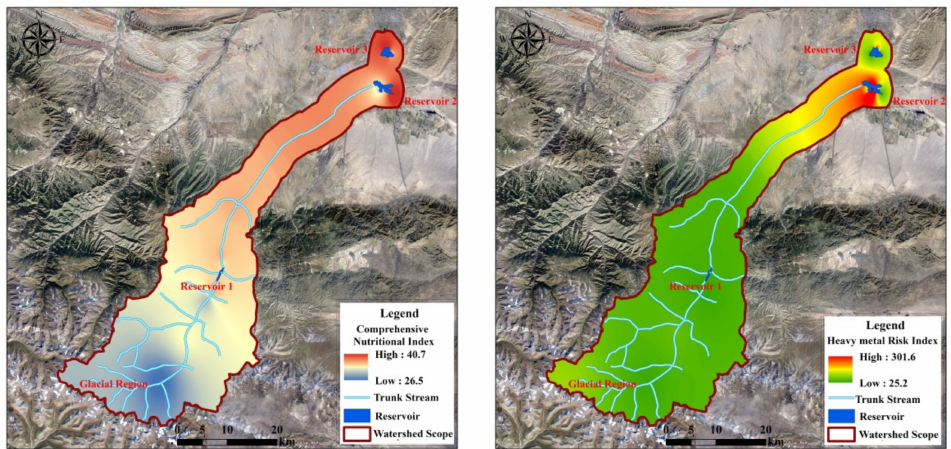
Figure 7. Scoring results for the comprehensive nutritional index ( left ) and potential heavy metals ecological risk index ( right